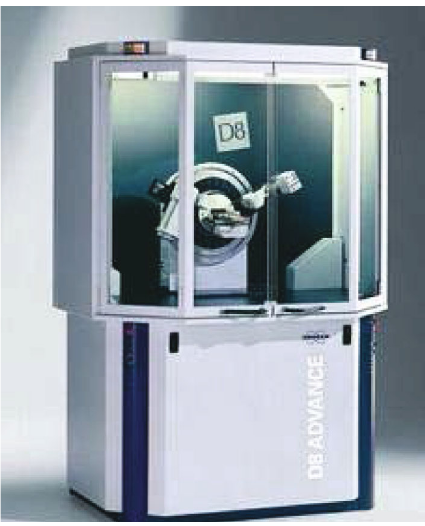
Figure 3: D8 DISCAPROCK X-ray di ff ractometer.